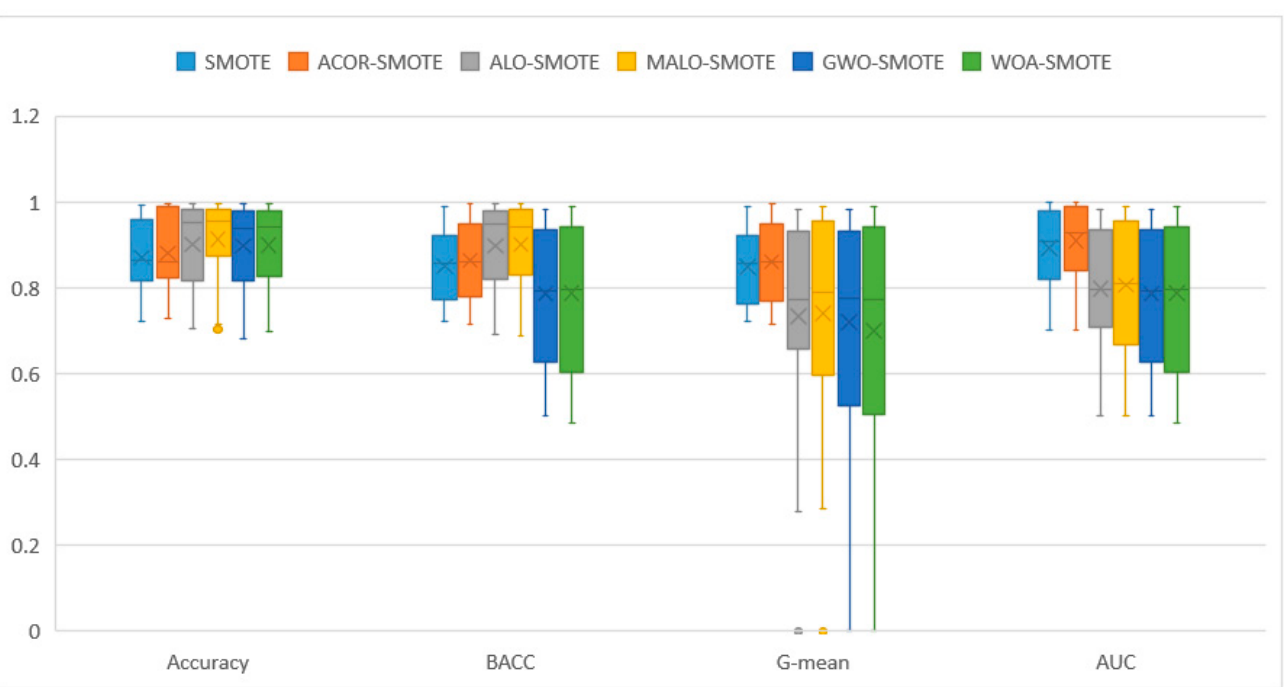
Figure 7. Box and whiskers plots for Accuracy, BACC, G-mean, and AUC of compared methods.